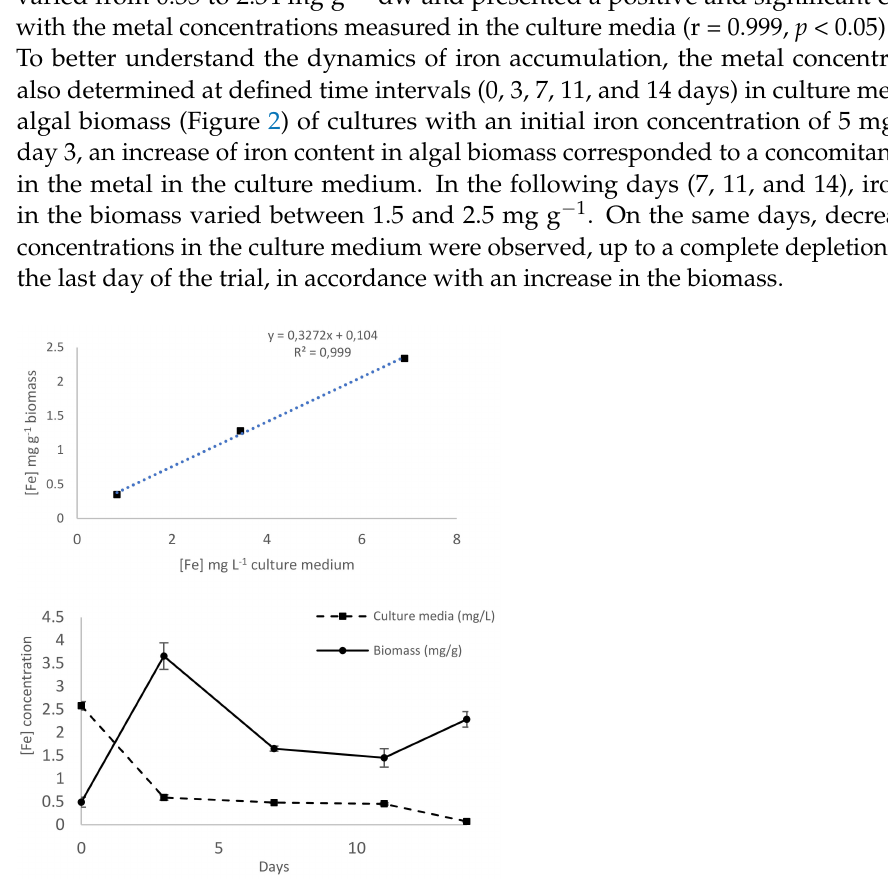
Figure 2. ( Top ) Iron accumulation in algal biomass as a function of iron concentration in the culture medium. ( Bottom ) Iron concentration in culture medium (dotted line reported as mg L − 1 ) and iron content in algal biomass (solid line reported as mg g − 1 dry wt) of cultures with an initial iron concentration of 5 mg L − 1 during a period of 14 days. Data are reported as mean ± SD ( n =